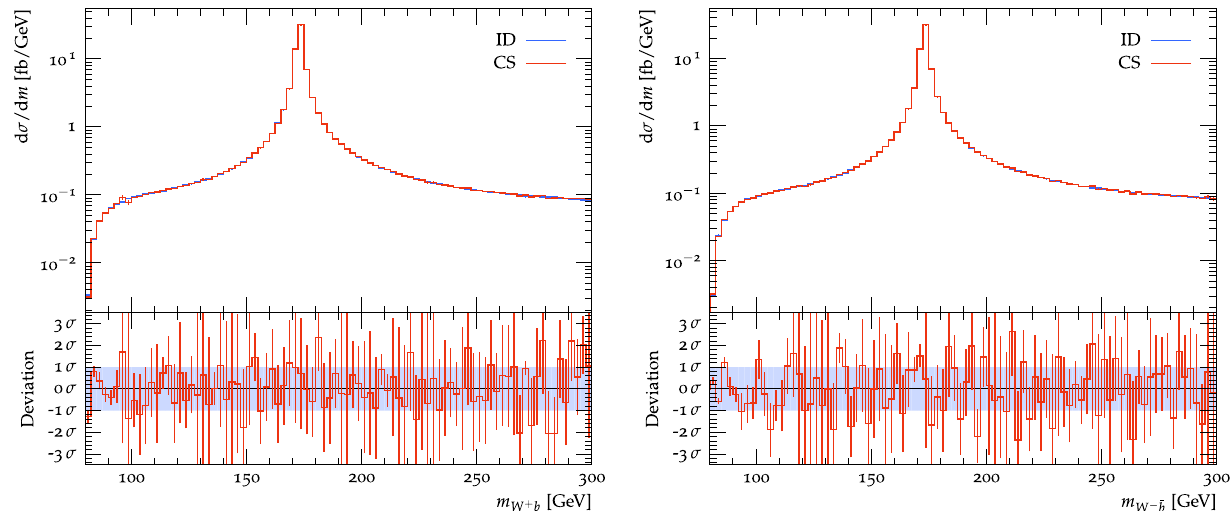
Fig. 11 Invariant mass of the (anti-)top quark reconstructed at the level of the W + W − b ¯ b final state from the W -boson and a b -jet with a matching signed flavor tag